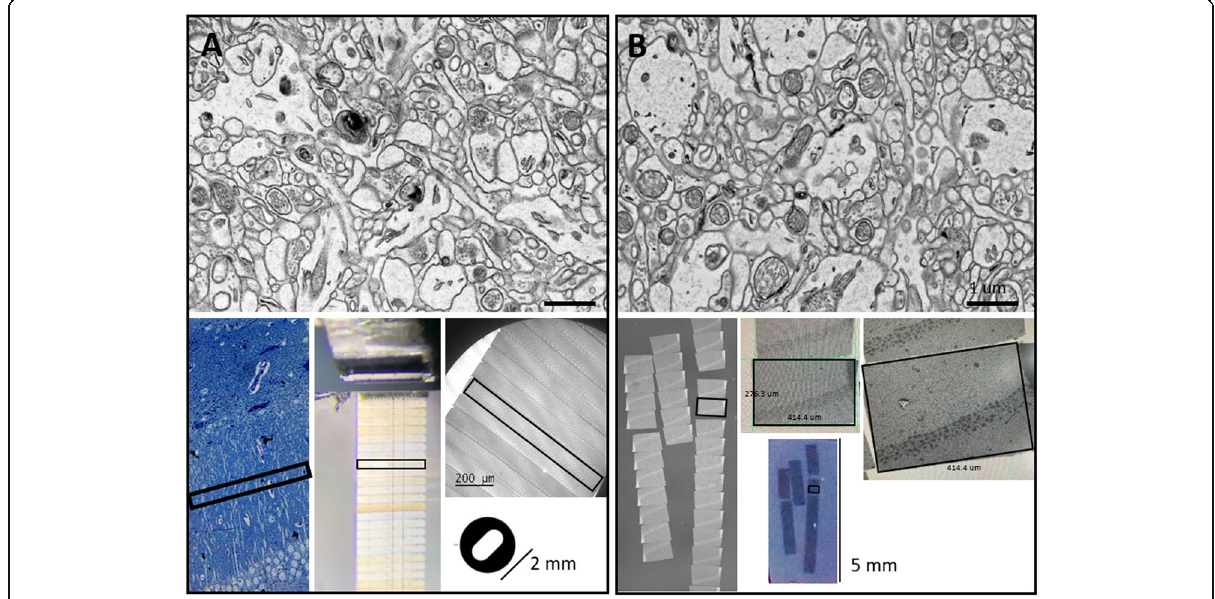
Fig. 1 Comparison of TEM and SEM imaging. a TEM imaging. b SEM imaging. Both images were taken from thin sections of a block with osmium tetroxide, excess thiocarbohydrazide (TCH), and osmium tetroxide staining (OTO). For TEM imaging, the region of interest (100 * 800 μ m) was trimmed, sectioned, and loaded onto a TEM grid. Unlike TEM, SEM imaging was selected from a large area (276.3 * 414.4 μ m) in SEM without trimming before